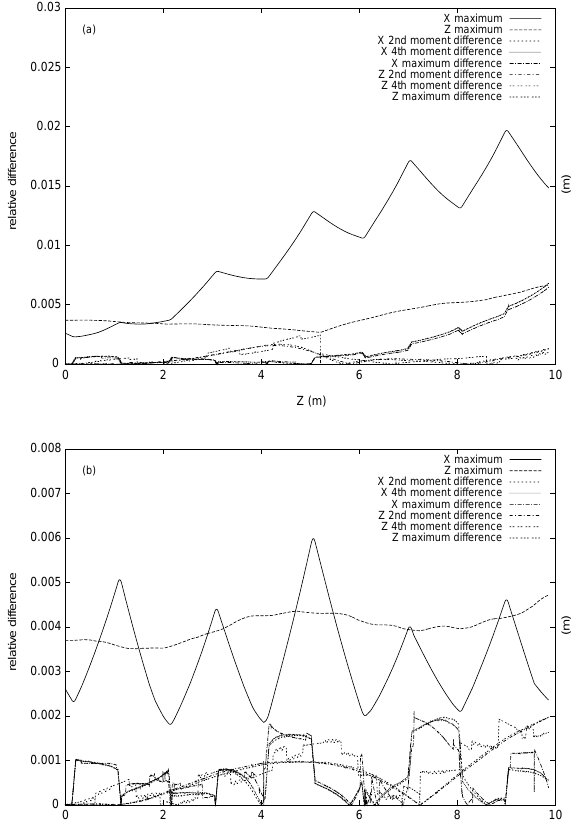
FIG. 6. The relative difference and maximum particle ampli- tude as a function of position for (a) weaker transverse focusing, and (b) stronger transverse focusing than the reference case.